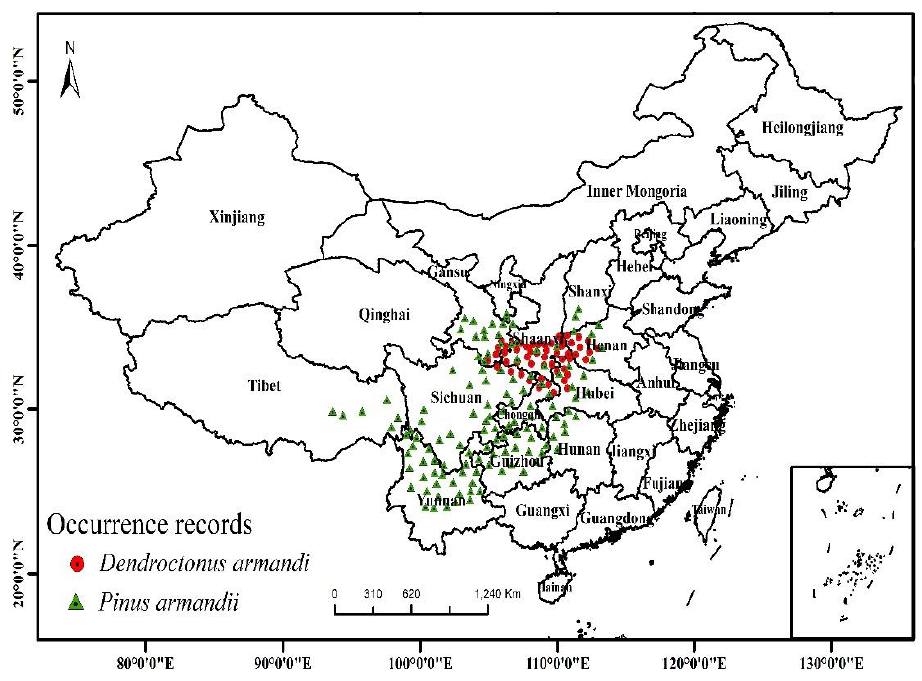
Figure 1. Occurrence records of Dendroctonus armandi and current distribution of Pinus armandii in China.